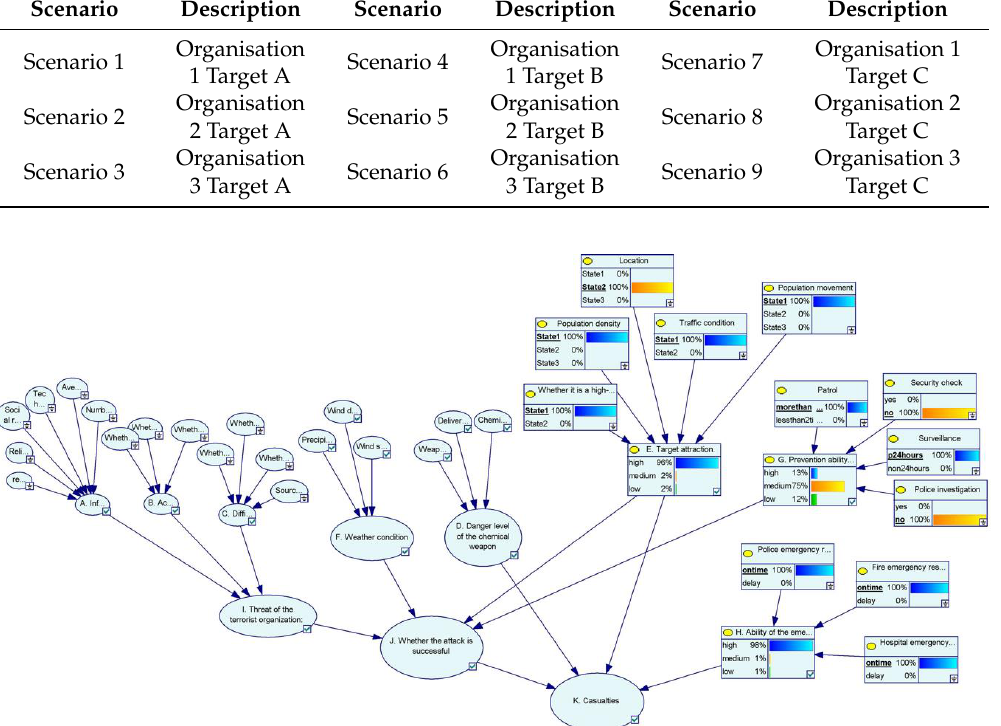
( a ) Estimated probabilities of ‘‘I. Threat of the terrorist organisation” under different organisations.